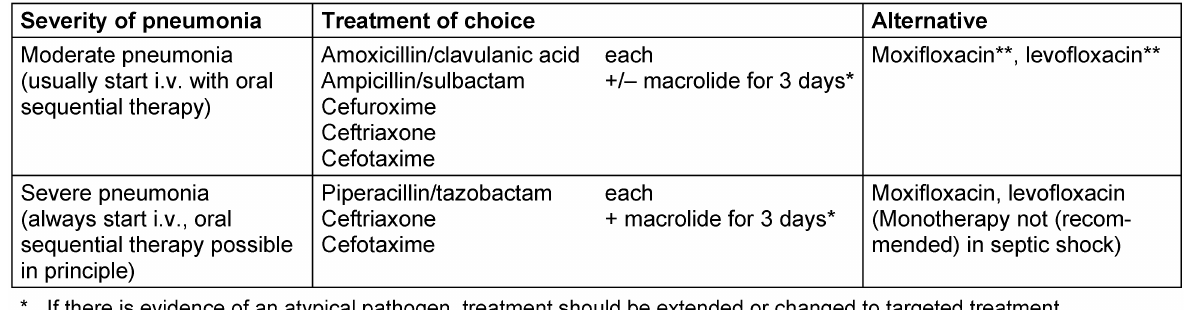
Table 4: Recommendation for the calculated initial treatment in moderate and severe hospitalized CAP without risk for